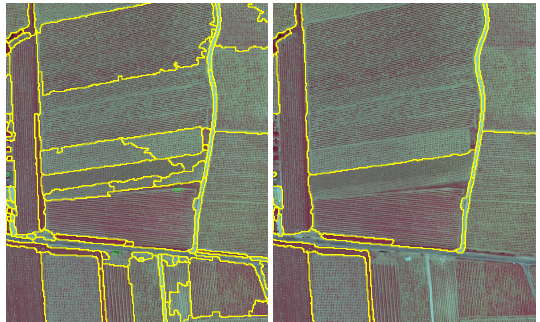
Figure 3: From left to right : example of a suitable and of a too coarse